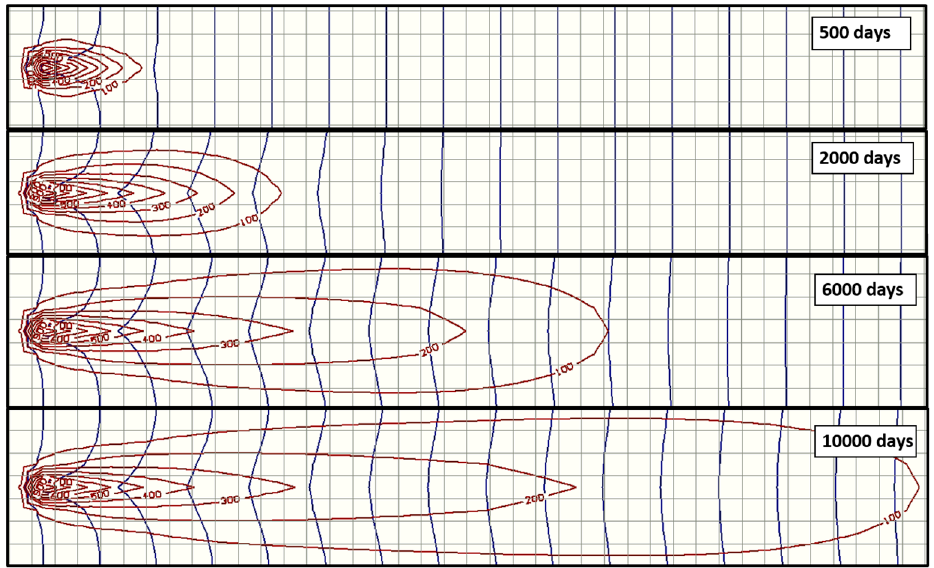
Figure 2. Iso-concentration patterns for different times in a large scenario with advection and diffusion. t = 500, 2000, 6000 and 10,000 days. The blue lines and grey network represent piezometric lines and cell extension (1m 2 ), respectively.